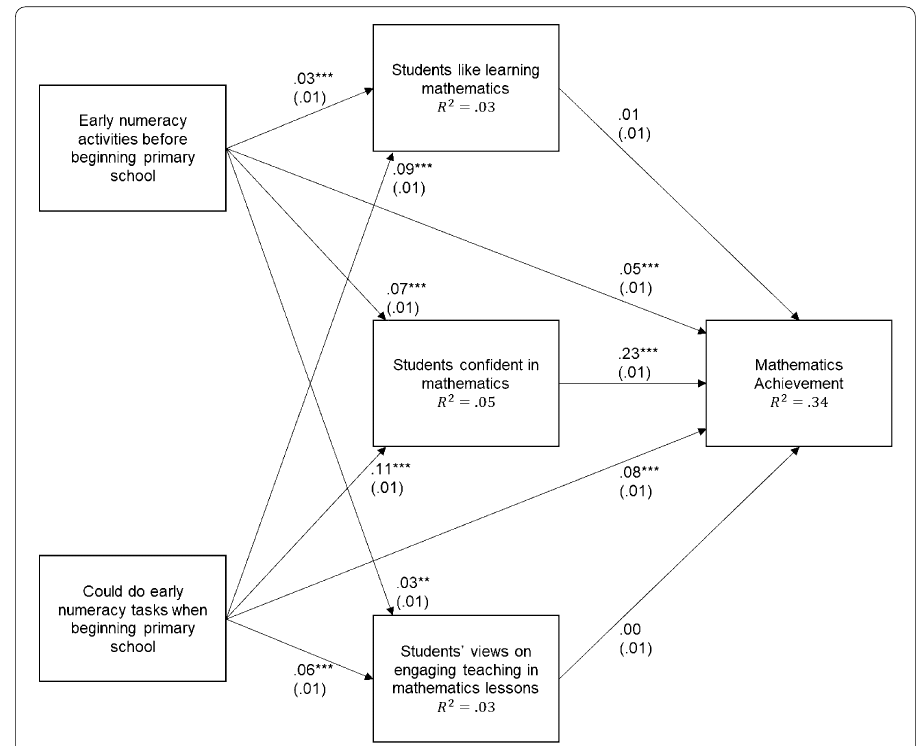
Fig. 2 Results of path analyses. Standard errors are in parentheses. The control variables were included in the analysis. For the sake of clarity, they are not included in the figure. **p < 0.01. ***p <